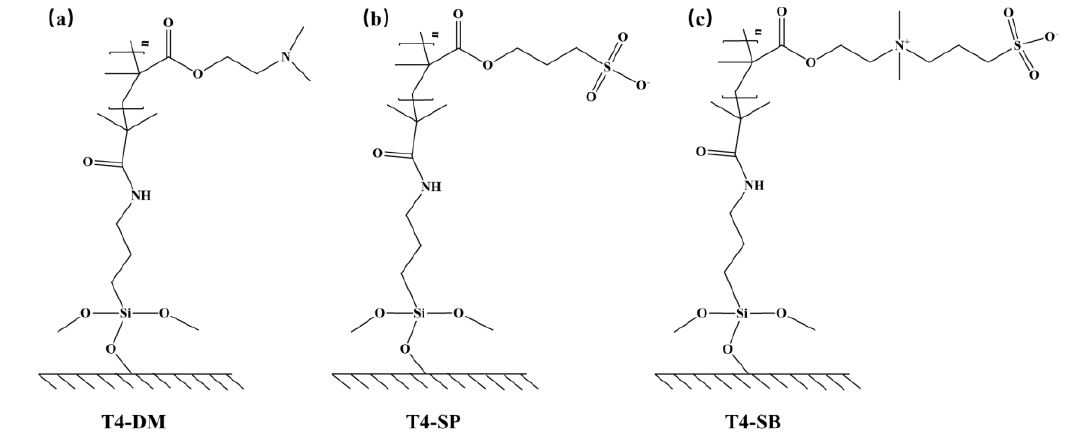
Figure 1. Chemical structure of three nonfouling membranes ( a ) T4-DM, ( b ) T4-SP, ( c ) T4-SB.